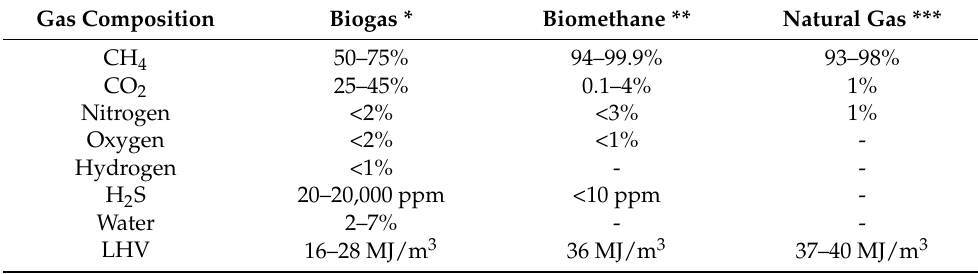
Table 1. Biogas, biomethane, and natural gas parameters comparison. Gas